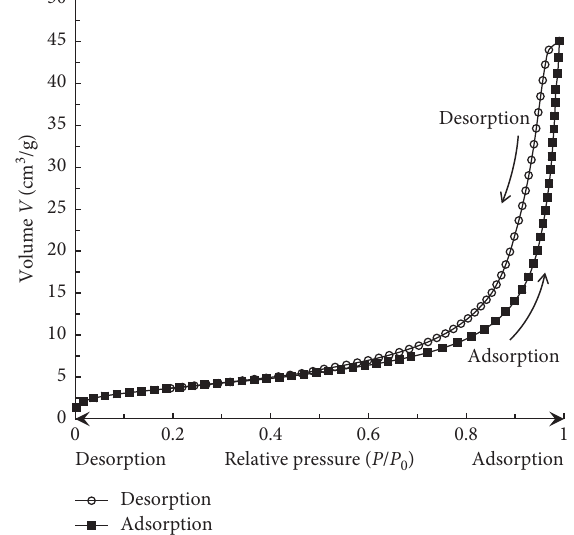
Figure 6: The adsorption isotherm of NCG